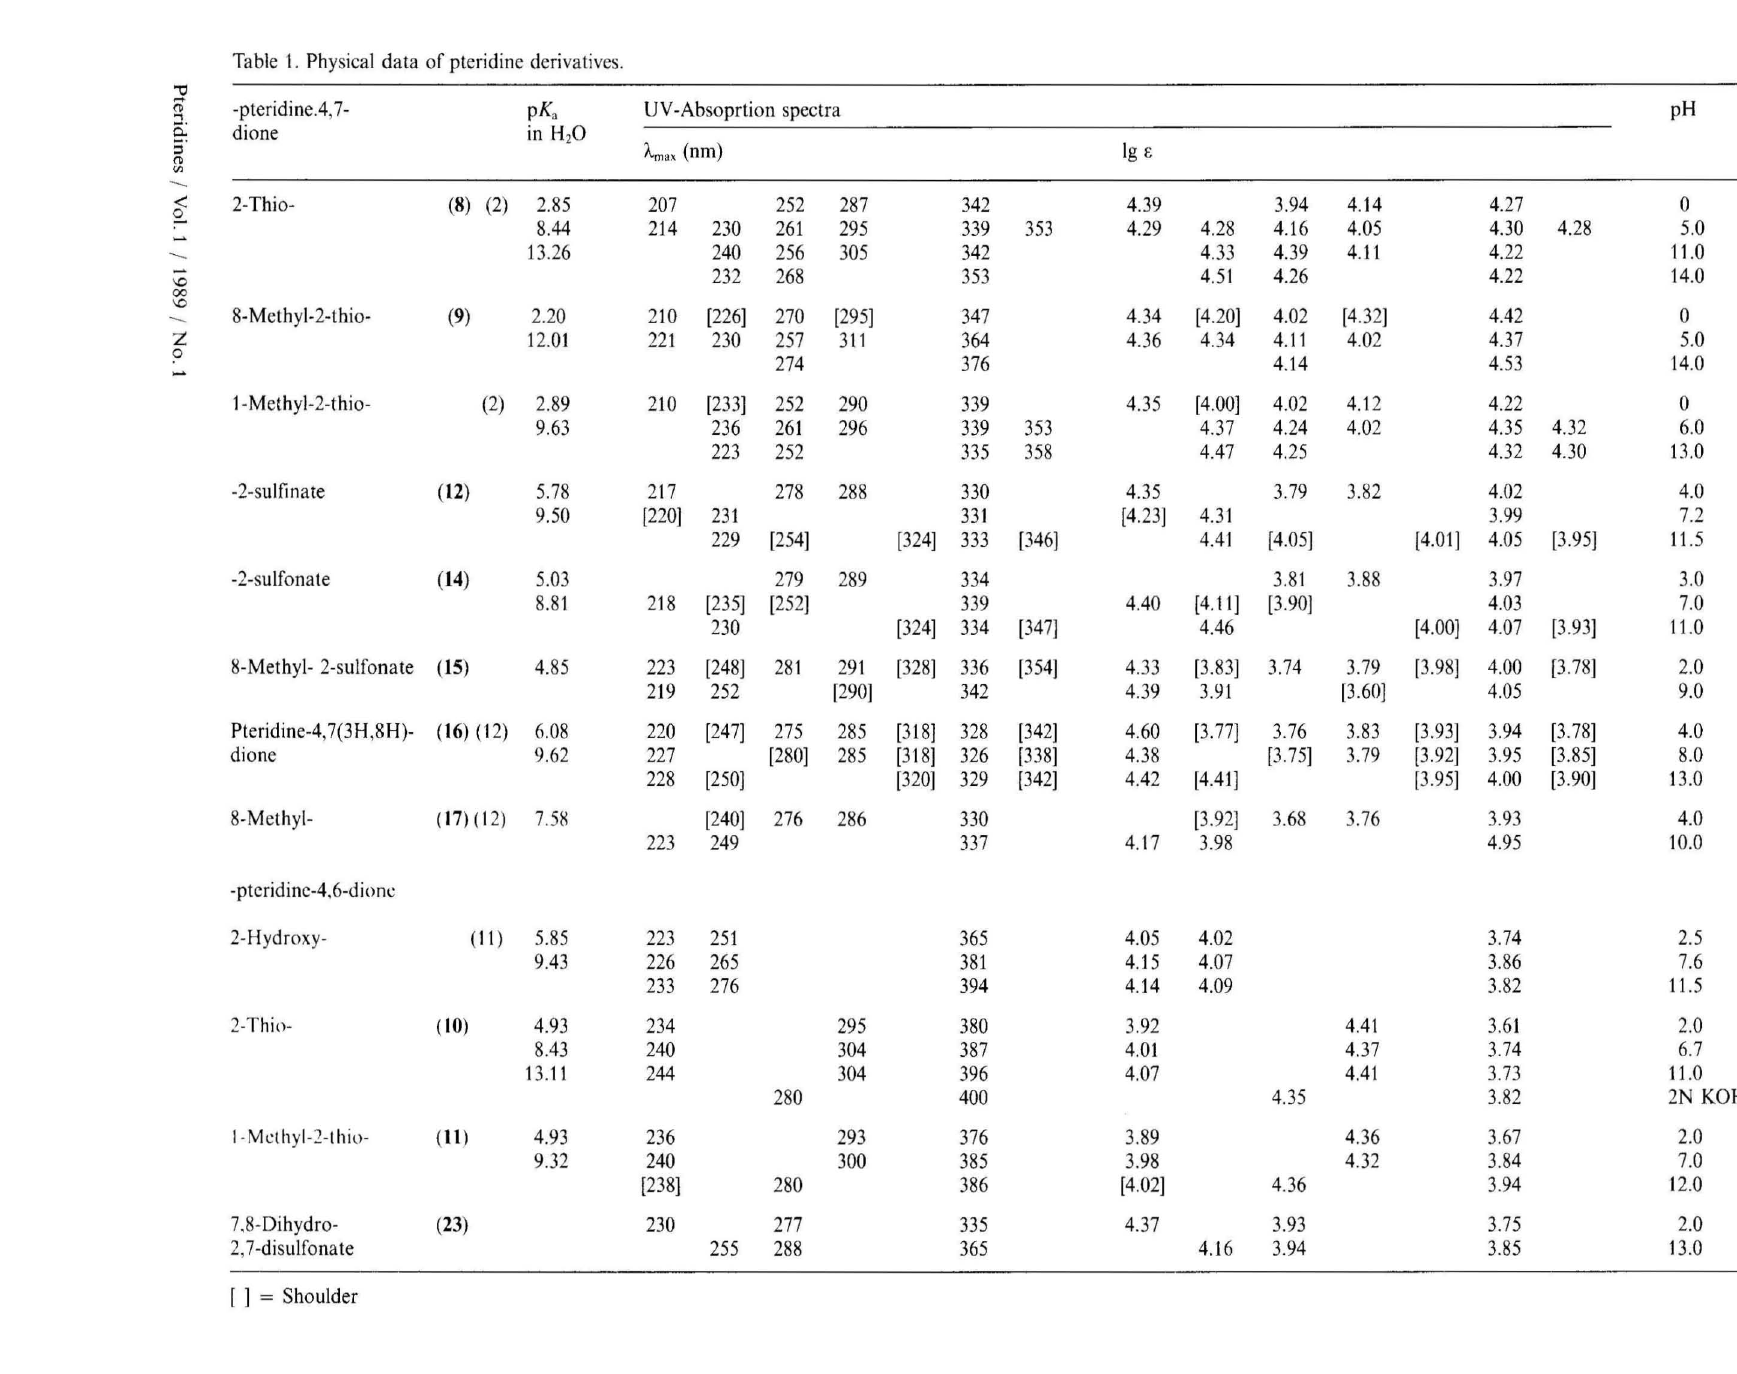
Table 1. Physical data of pteridine